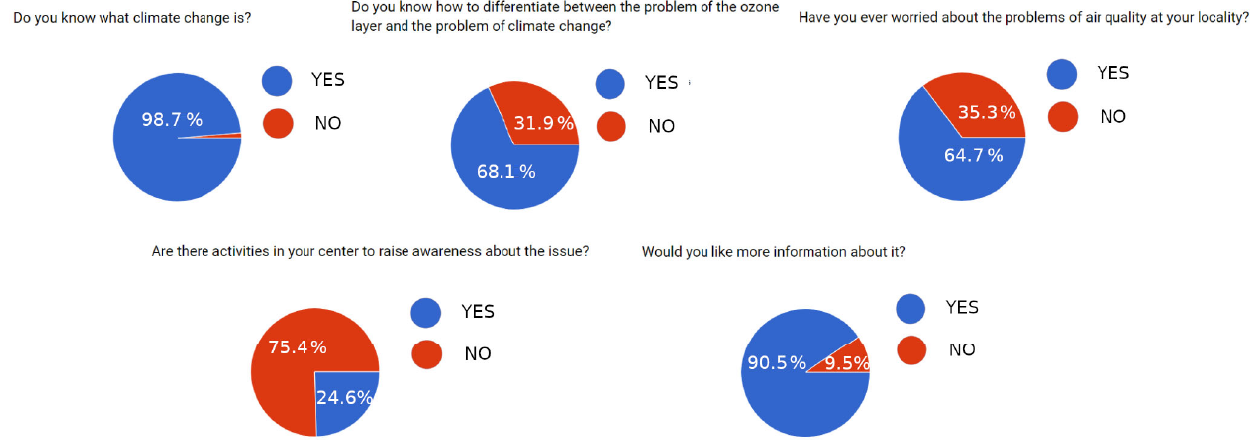
Figure 2. The five most relevant questions related to knowledge acquired through practice: “Do you know what climate change is?” received almost universally positive responses; “Do you know how to differentiate between the problem of climate change and the problem of the ozone layer?” resulted in around one-third negative answers; “Have you ever worried about the problems of air quality in your neighbour- hood?” received the proportion of responses as the previous question; “Are there activities in your area to raise awareness of this issue?” produced three-quarters negative response; “Would you like more information about it?” received almost universally positive answers.